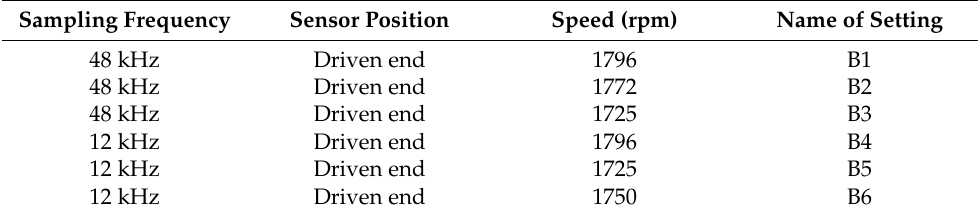
Table 2. Working conditions settings of Case Western Reserve University (CWRU)